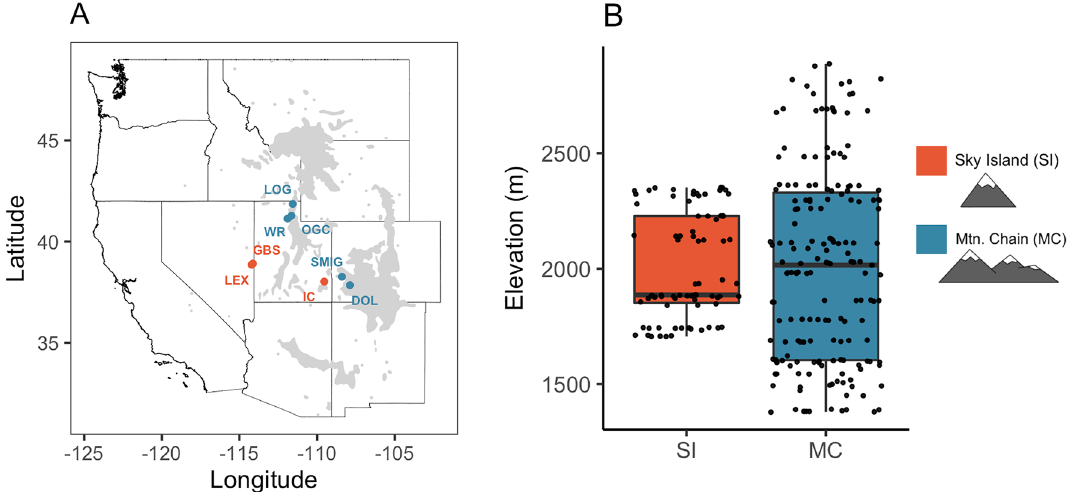
Figure 1. Study sites are distributed across the natural range of Populus angustifolia and do not differ in elevational range. ( A ). Map of riparian study sites across the intermountain western U.S. Sky islands (SI) are indicated in orange, n = 3 (IC, Indian Creek, UT; LEX, Lexington Creek, NV; GBS, Great Basin, NV), and mountain chains (MC) are indicated in blue, n = 5 (DOL, Dolores River, CO; LOG, Logan River, UT; OGC, Ogden Canyon, UT; SMIG, San Miguel River, CO; WR, Weber River, UT). The Populus angustifolia natural range is shaded in grey. ( B ). The average sampling elevation across the study sites is not significantly different between SI and MC, showing that environmental variation is not determined by